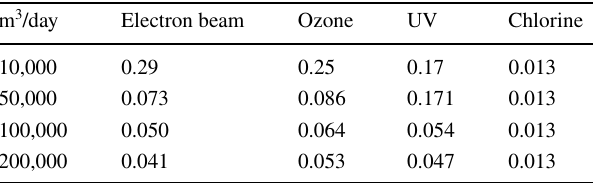
Table 4 Comparative cost estimation of conventional and radiation- based technology for waste water treatment (US $/m 3